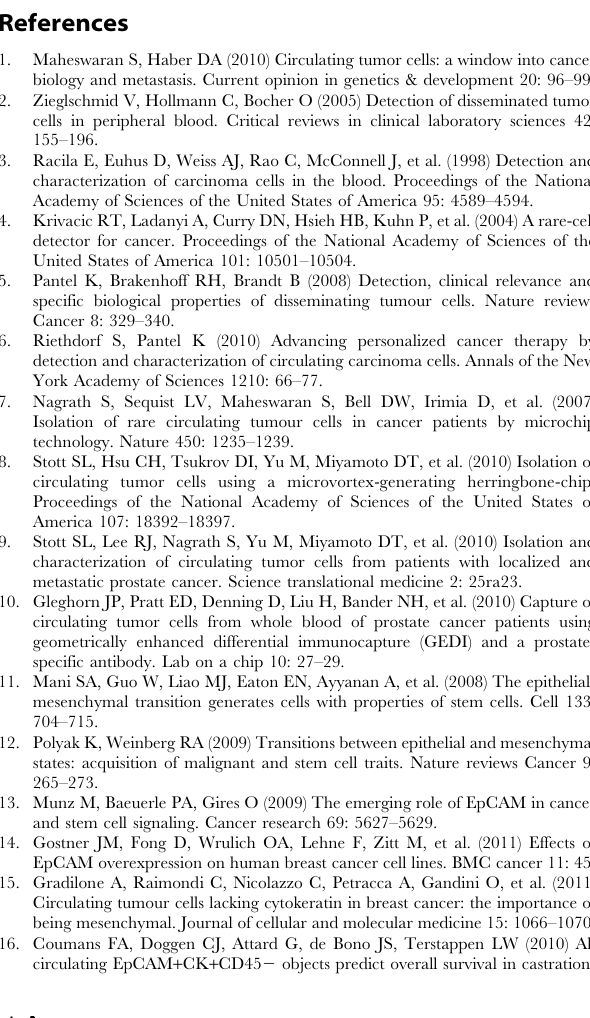
CTC from the same patient (bottom panel, standard arrow). The adjacent leucocyte (PSMA 2 ) shows clear microtubule bundling in response to PTX treatment. (TIFF) Figure S5 PSMA and EpCAM expression in CRPC patient CTCs isolated using CD45 2 immunodepletion. (A) Table showing the percentage of both PSMA and EpCAM positive CTCs from CRPC patients obtained using CD45- immunodepletion. (B) Representative images of CTCs isolated from 2 prostate cancer patients, stained for PSMA (Green) and EpCAM (Red) and analyzed by point scanning confocal microscopy. Scale Bar= 10 m m. The yellow arrows point to PSMA + /EpCAM dim staining. Notice the variability in EpCAM fluorescence intensity within each sample.